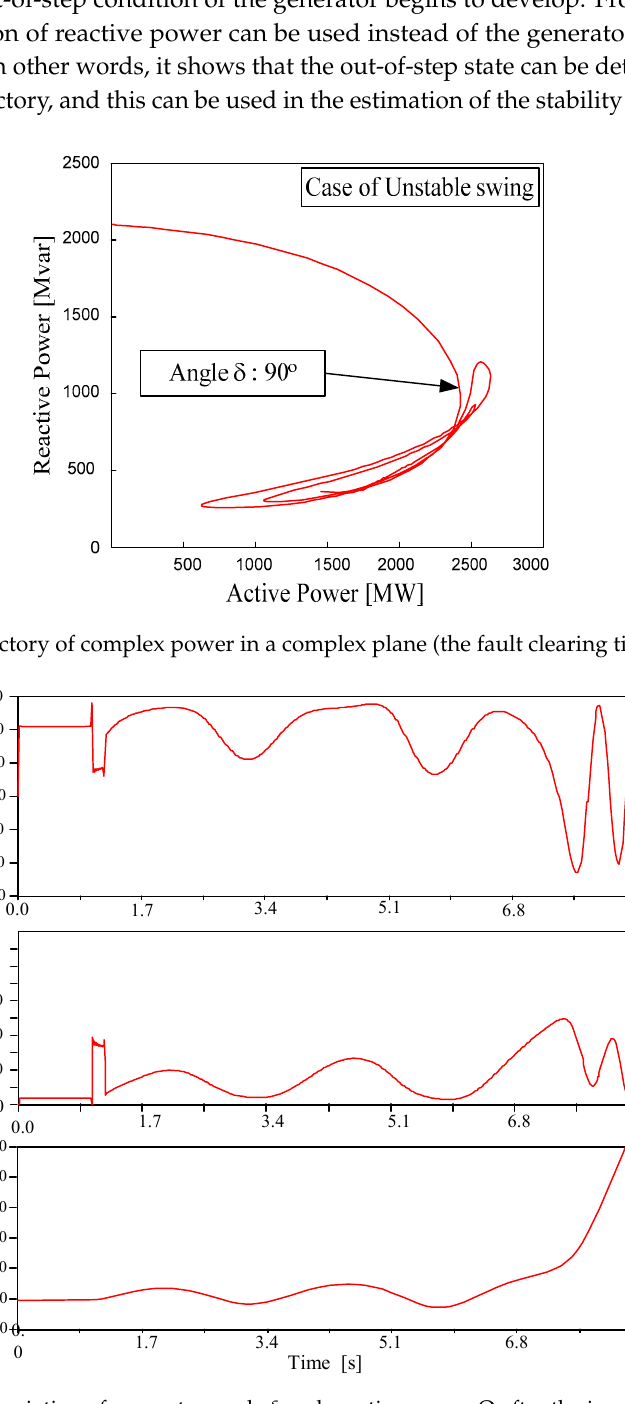
Figure 10. Time variation of generator angle δ and reactive power Q after the occurrence of the fault.